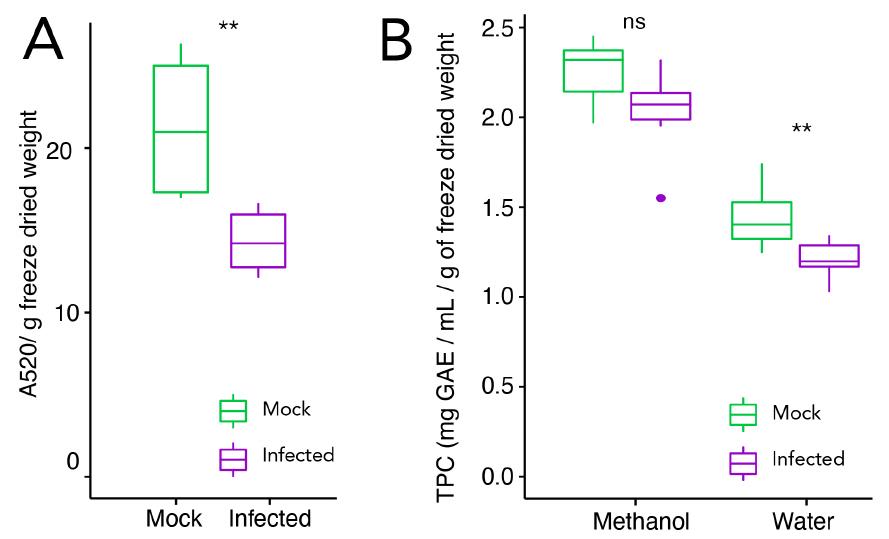
Figure 2. Evaluation of ( A ) total anthocyanins content (absorbance 520nmg −1 freeze dried weight) and ( B ) total phenolic content (TPC) extracted with methanol or water (gallic acid equivalent (GAE) mgmL −1 g −1 freeze dried weight) in V. vinifera cv. Trincadeira grapes at the harvest stage (EL38) (mock and B. cinerea infected). Box-and-whisker plots represent the minimum, first quartile, sample median, third quartile, maximum, and outliers. Total anthocyanins data were analysed with the Wilcoxon–Mann–Whitney test, and TPC data were analysed with the t -test. Asterisks indicate significant differences between control and infected samples within each method: ** p value < 0.01; ns: not